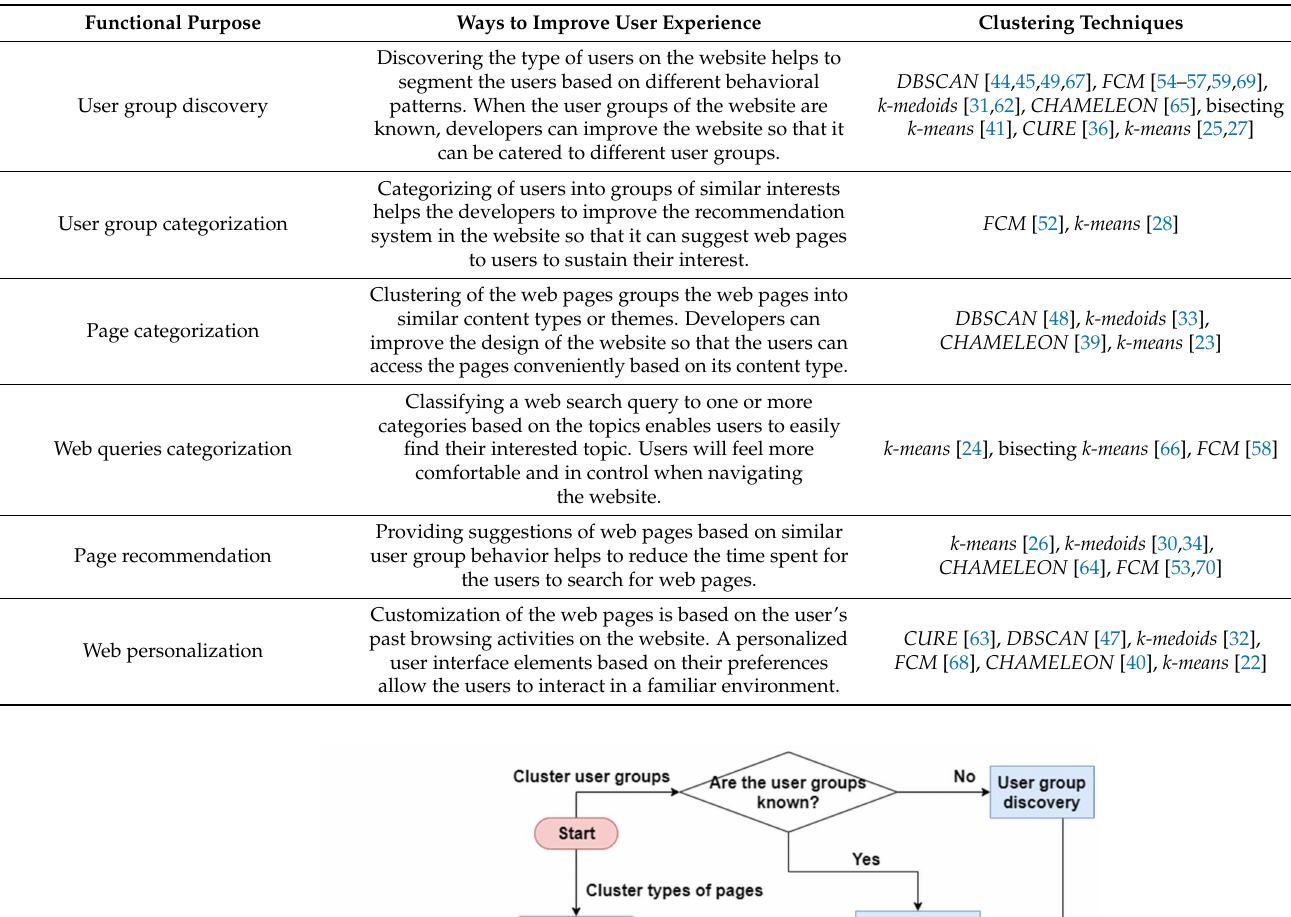
Table 6. Functional purpose and ways to improve user experience.